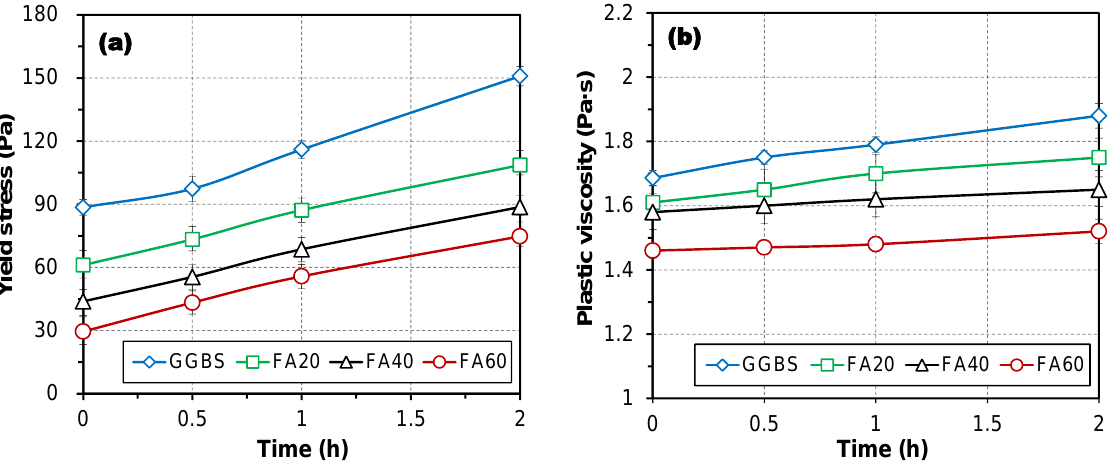
Figure 5. FA ’s effect on AAS-CPB yield stress ( a ) and plastic viscosity ( b ). Figure 5. FA’s effect on AAS-CPB yield stress ( a ) and plastic viscosity ( b